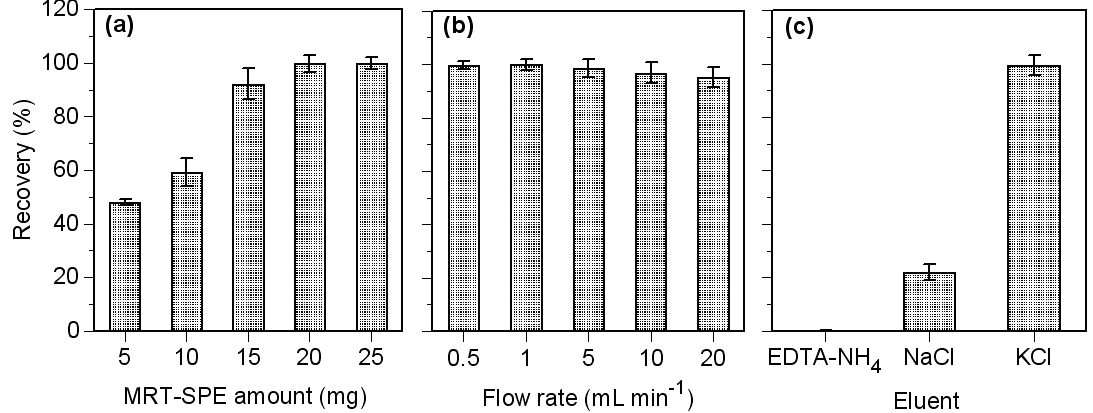
Figure 1. Performance optimization of the MRT-SPE material: effect of (a) MRT-SPE amount, (b) sample loading flow rates, and (c) different eluents